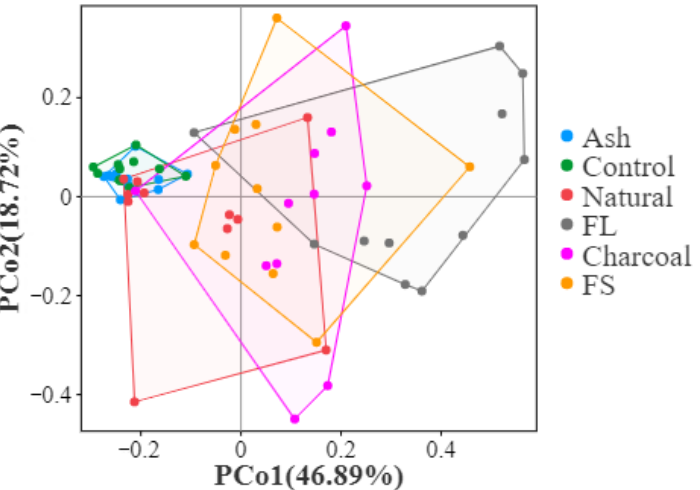
Figure 6. Principal coordinates analysis (PCoA) ordination plot showing the changes of nematode- trapping fungi (NTF) communities in each treatment at different time points. FS: treated with flame gun and the burn duration was 20 min; FL: treated with flame gun and the burn duration was 60 min; Charcoal: treated with Charcoal; Ash: treated with cooled ash; Natural burning: treated with dry pine needles placed directly on the soil and let burn naturally and ashes were left on the soil after burn; Control: without any treatment.